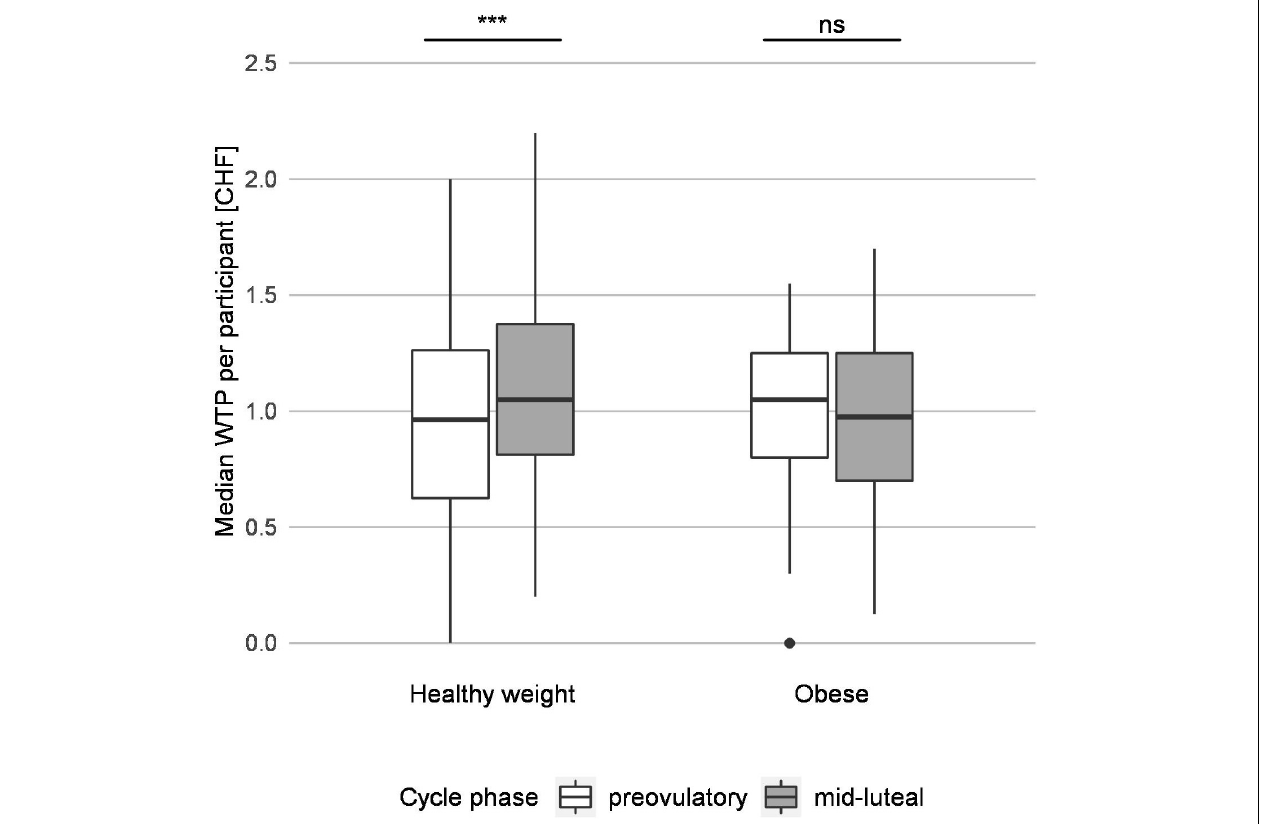
FIGURE 2 | Group testing reveals that pre-ovulatory and mid-luteal willingness to pay (WTP) differs for participants with healthy weight but not for participants with obesity. The median WTP per participant for participants with normal weight and with obesity are depicted. The white and the gray boxes represent the median WTP per participant in the pre-ovulatory and mid-luteal cycle phase, respectively, and indicate the range of the data from the first to the third quartile. The horizontal line represents the median, and the whiskers reach to the minimal and maximal values not considered outliers; one outlier is represented by a dot. Group comparisons revealed a significant difference in WTP between pre-ovulatory and mid-luteal cycle phase for participants with healthy weight but not for participants with obesity. *** p < 0.001, ns, not